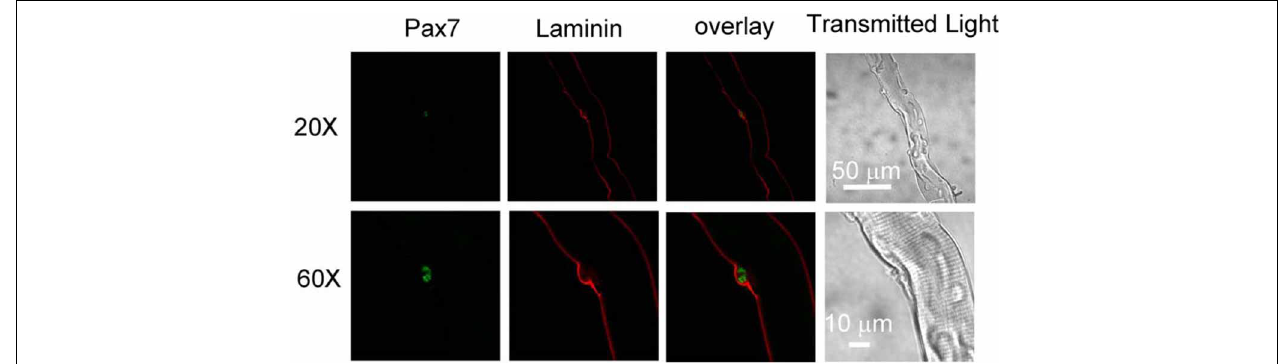
FIGURE 1 | Satellite cells locate between basal lamina and host FDB in collagenase dissociated FDB cultures. FDB fiber cultures were fixed with paraformaldehyde and immunostained with anti-laminin anti-Pax7, followed by appropriate secondary antibodies.